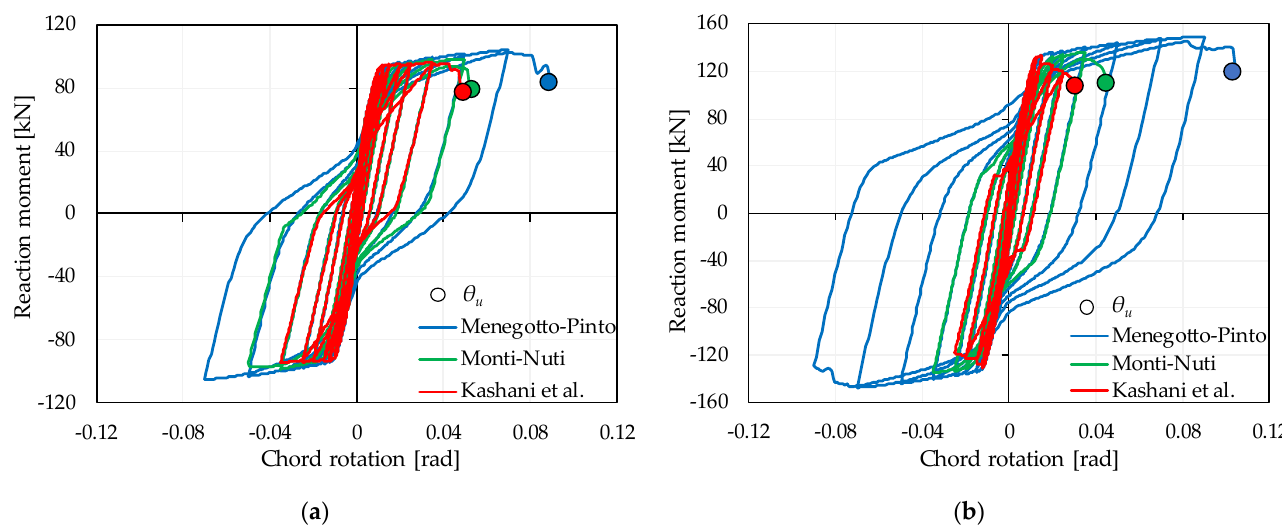
Figure 7. Reaction moment-chord rotation curve obtained from NLFEA: ( a ) column s150, ( b ) column φ22.